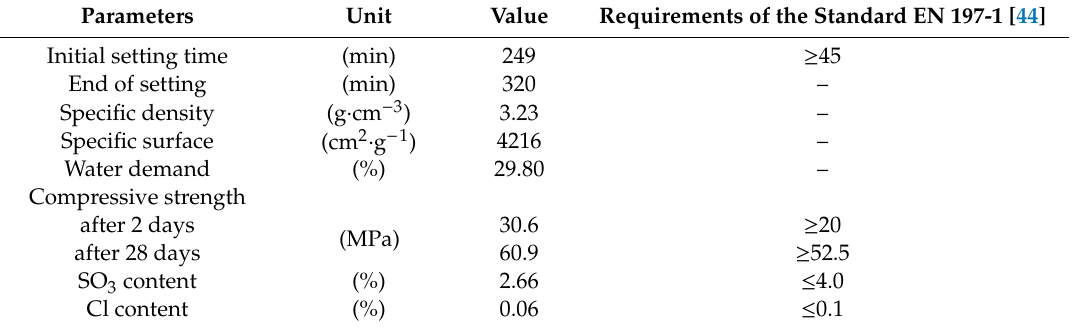
Table 4. Technical parameters of CEM I 52.5 HSR Portland cement (on the basis of the manufacturer’s information